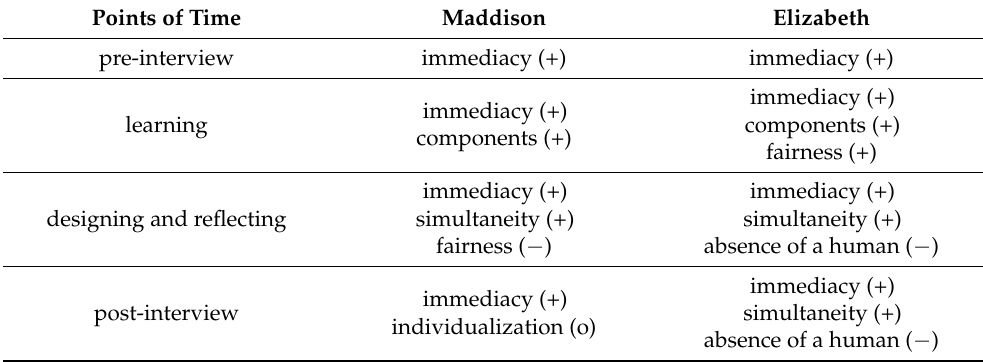
Table 4. Maddison’s and Elizabeth’s beliefs about digital feedback during the semester. Points of Time